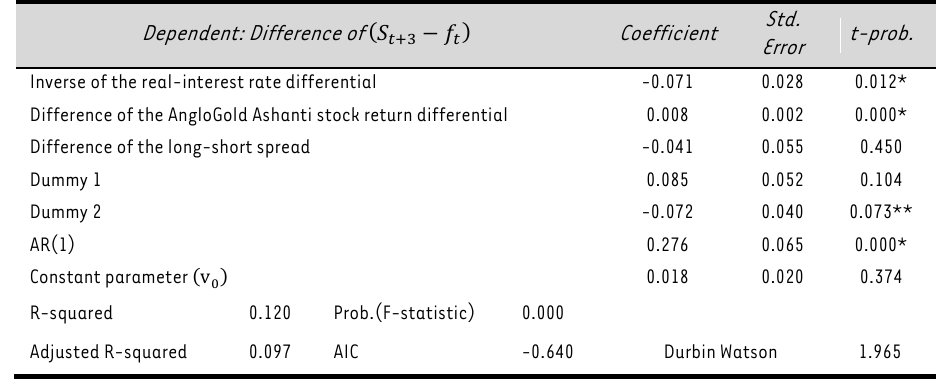
The ARCH(1,0) multi-variable model – fractionally differenced approach Std. Dependent: Fractionally differenced Coefficient t-prob. error Fractionally differenced real-interest rate differential -0.026 0.012 0.033* ( 𝑆 𝑡+3 − 𝑓 𝑡 ) Fractionally differenced Sappi Limited stock return differential -0.030 0.002 0.000* Fractionally differenced long-short spread 0.084 0.032 0.008* Intercept -0.417 0.046 0.000* Variance equation Intercept 0.019 0.003 0.000* Residual(-1)^2 0.733 21.303 Log likelihood Sum squared residuals Adjusted R-squared 0.128 SIC -0.040